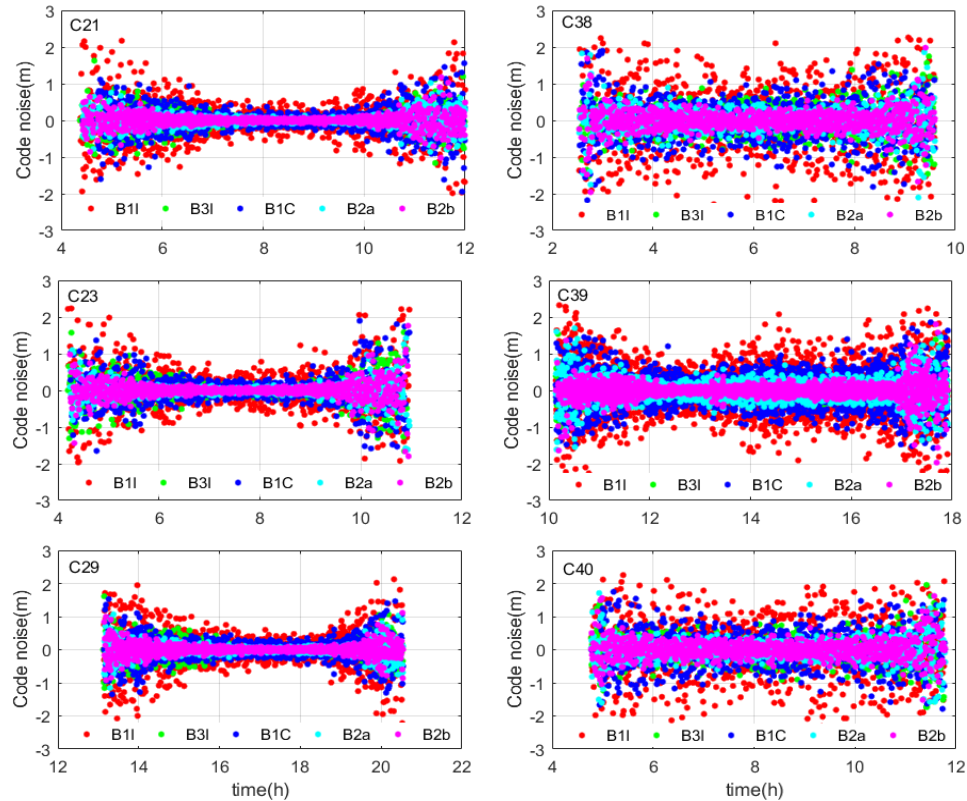
Figure 6. The pseudo-range noise series of BDS-3 satellites in different frequencies. Table 3. RMS statistics of observation quality for BDS-3 IGSOs and MEOs.